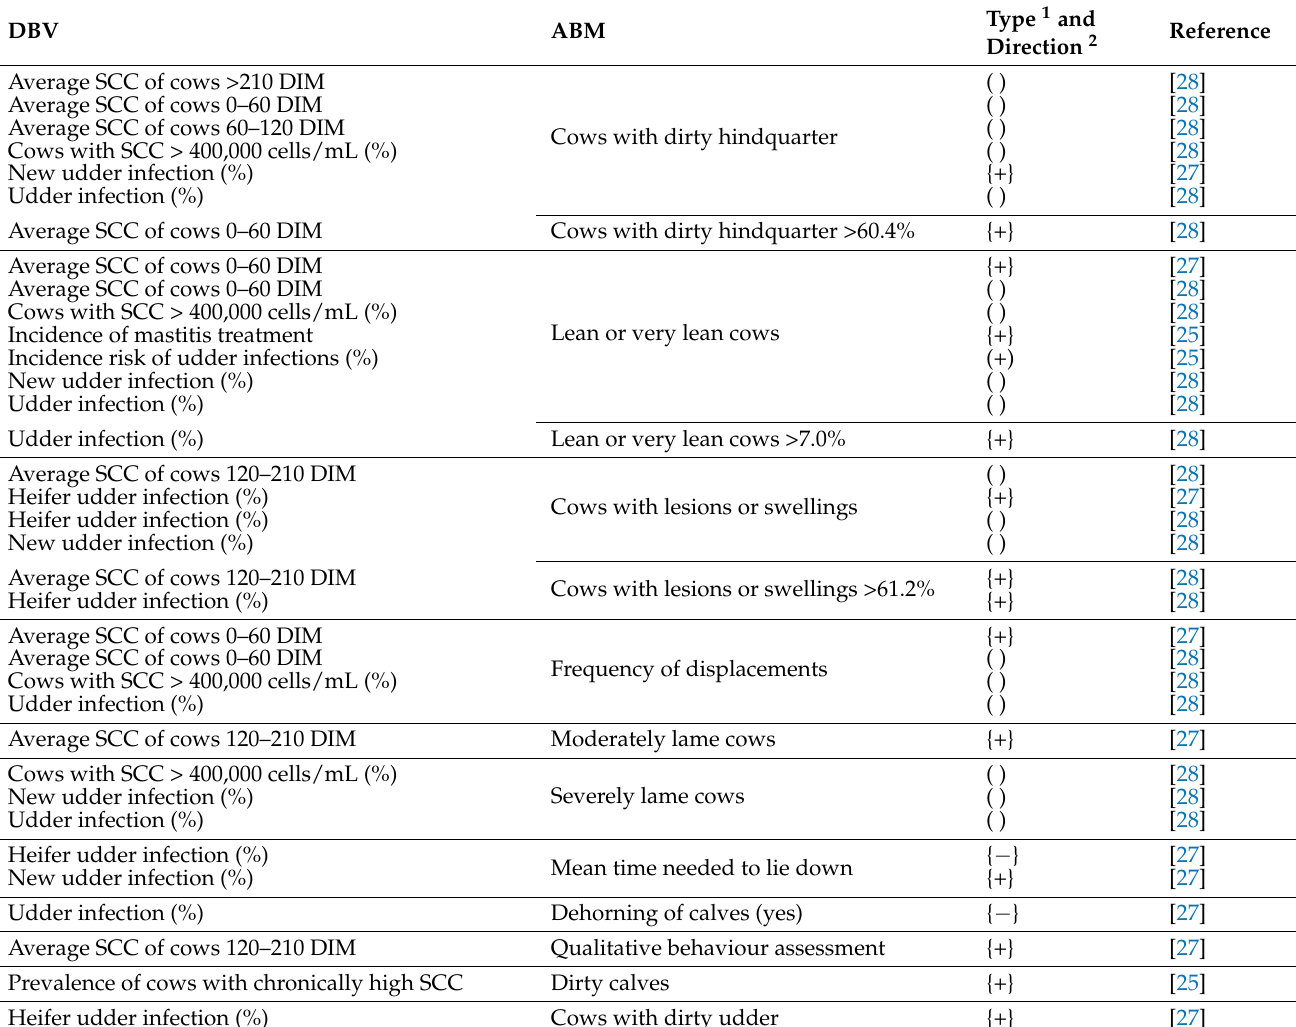
Table 7. Associations between data-based variables (DBVs) related to udder health and animal-based measurements (ABMs) extracted from three scientific